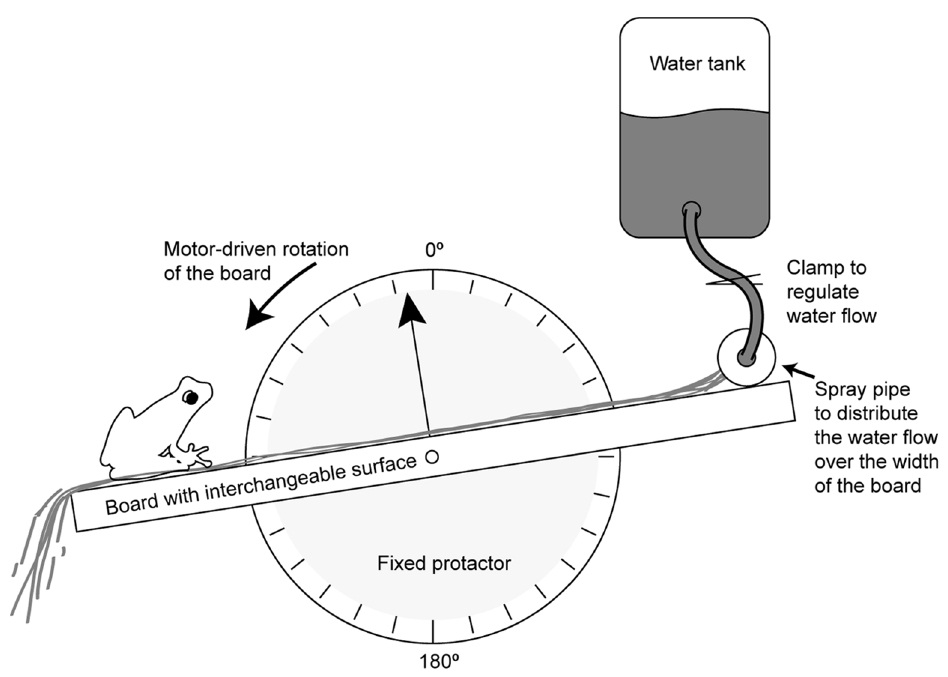
Figure 2. Diagram of the key elements of the tilting platform. Not drawn to scale.